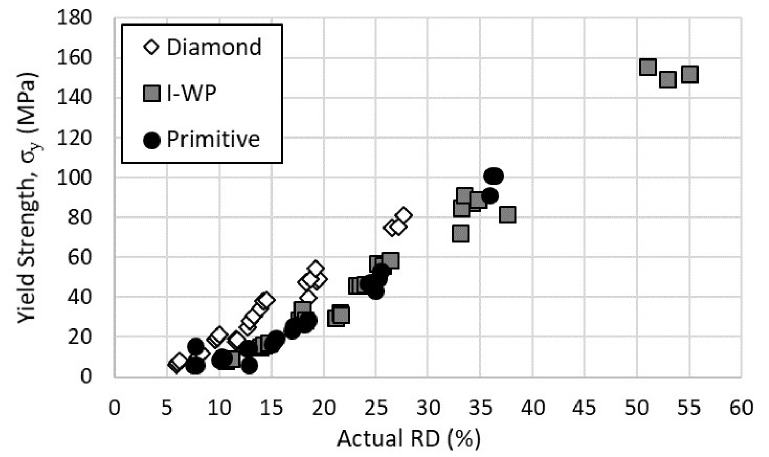
Figure 7. Yield strength versus actual relative density of lattice